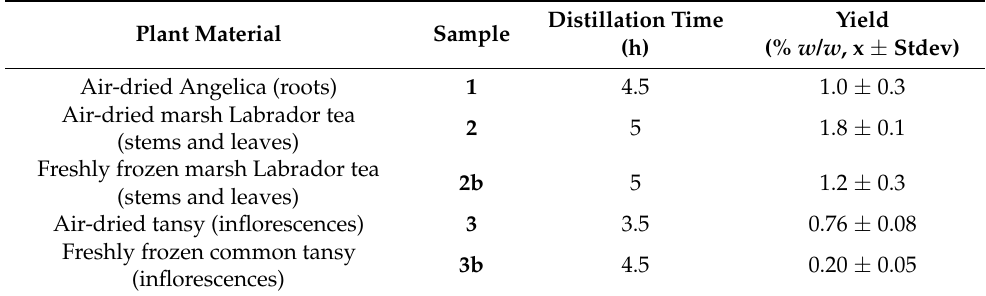
Table 1. Optimised steam distillation conditions and yields (x ± stdev) of the studied plant materials.